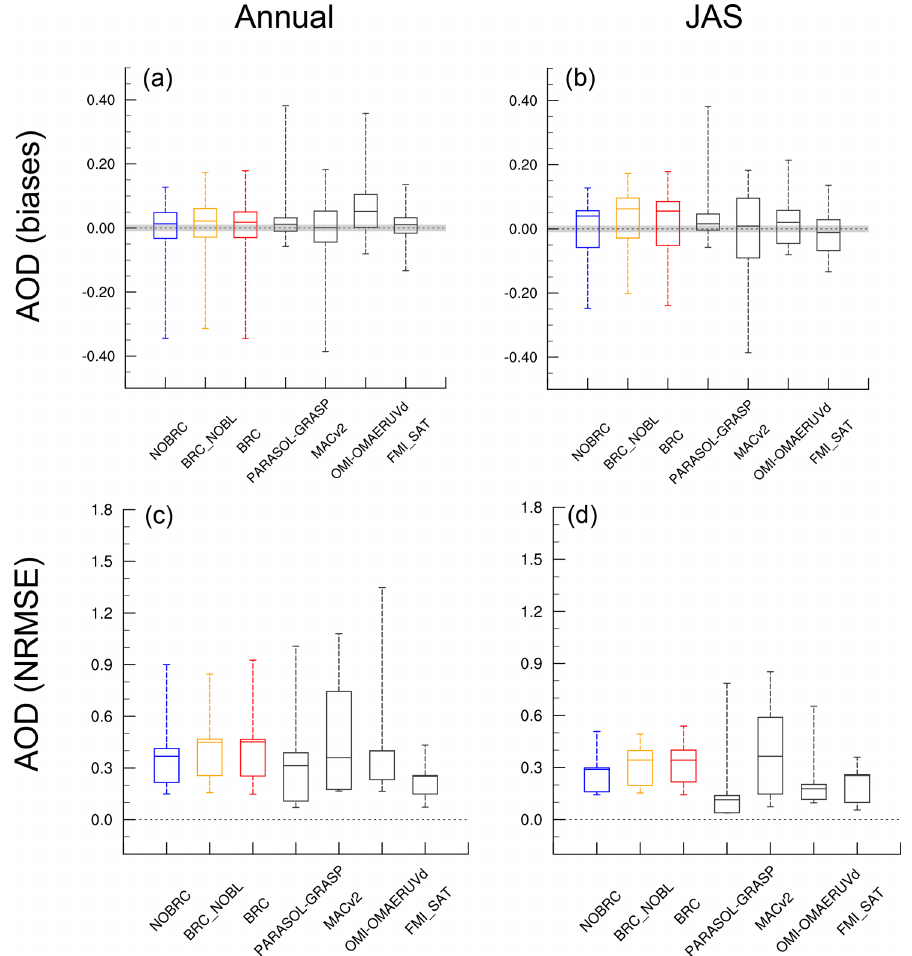
Figure A2. Boxplots of AOD (550nm) various biases (a, b) and normalized root mean square error (NRMSE, c, d ) compared to the AERONET observations, over the year (a, c) and over JAS (b, d) . Simulations: NOBRC, BRC_NOBL, and BRC (see Table 3 for details) and reference data sets (PARASOL-GRASP, OMI-OMAERUVd, MACv2, FMI_SAT; see Table 2 for details). Uncertainty of the AERONET observations appears